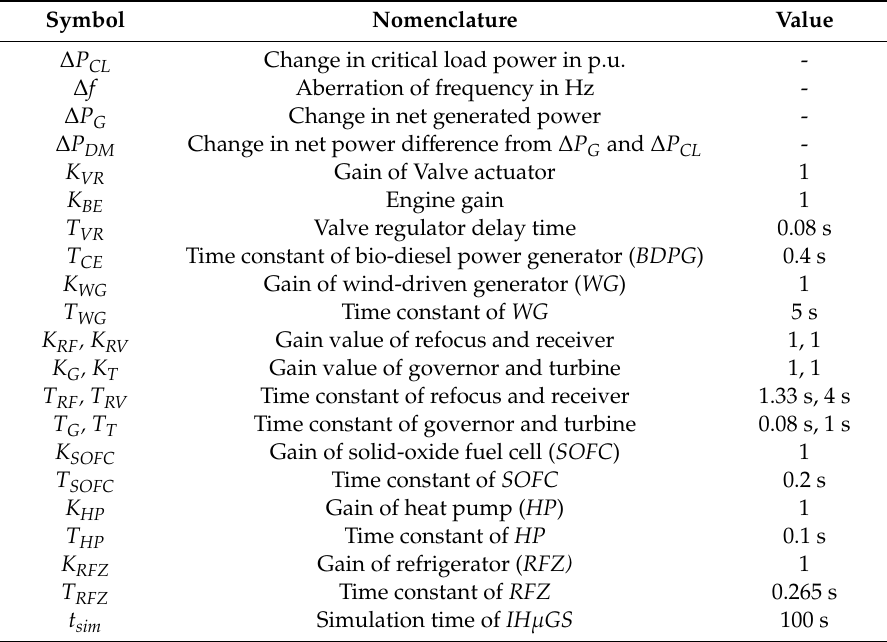
Table 1. Utilized symbols and abbreviations.